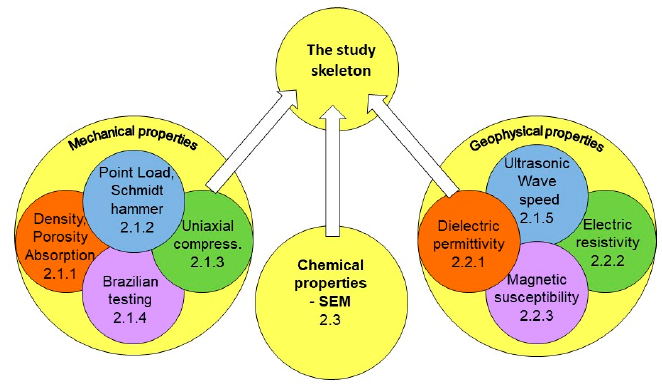
Figure 4. The study skeleton consists of three main phases.